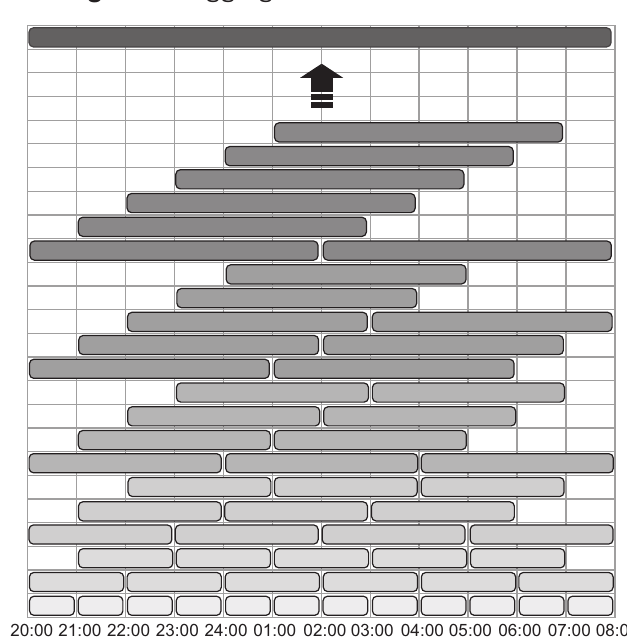
Figure 7. Aggregation of vehicles into